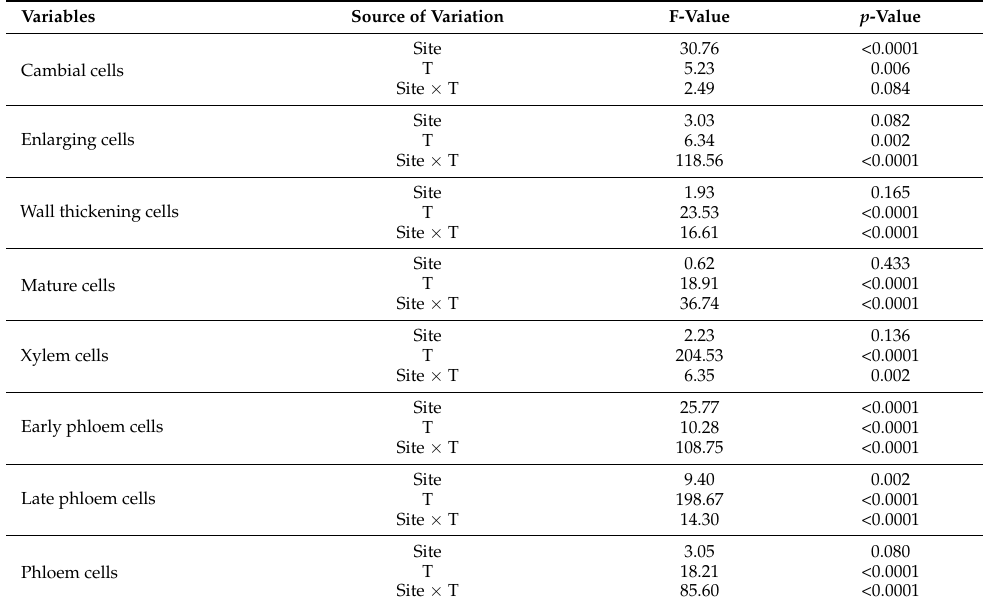
Table 3. Mixed-effects model and ANOVA results showing the effects of different sites (Site), periods (T), and their interactive effects on the xylem and phloem formation of Picea crassifolia . Variables